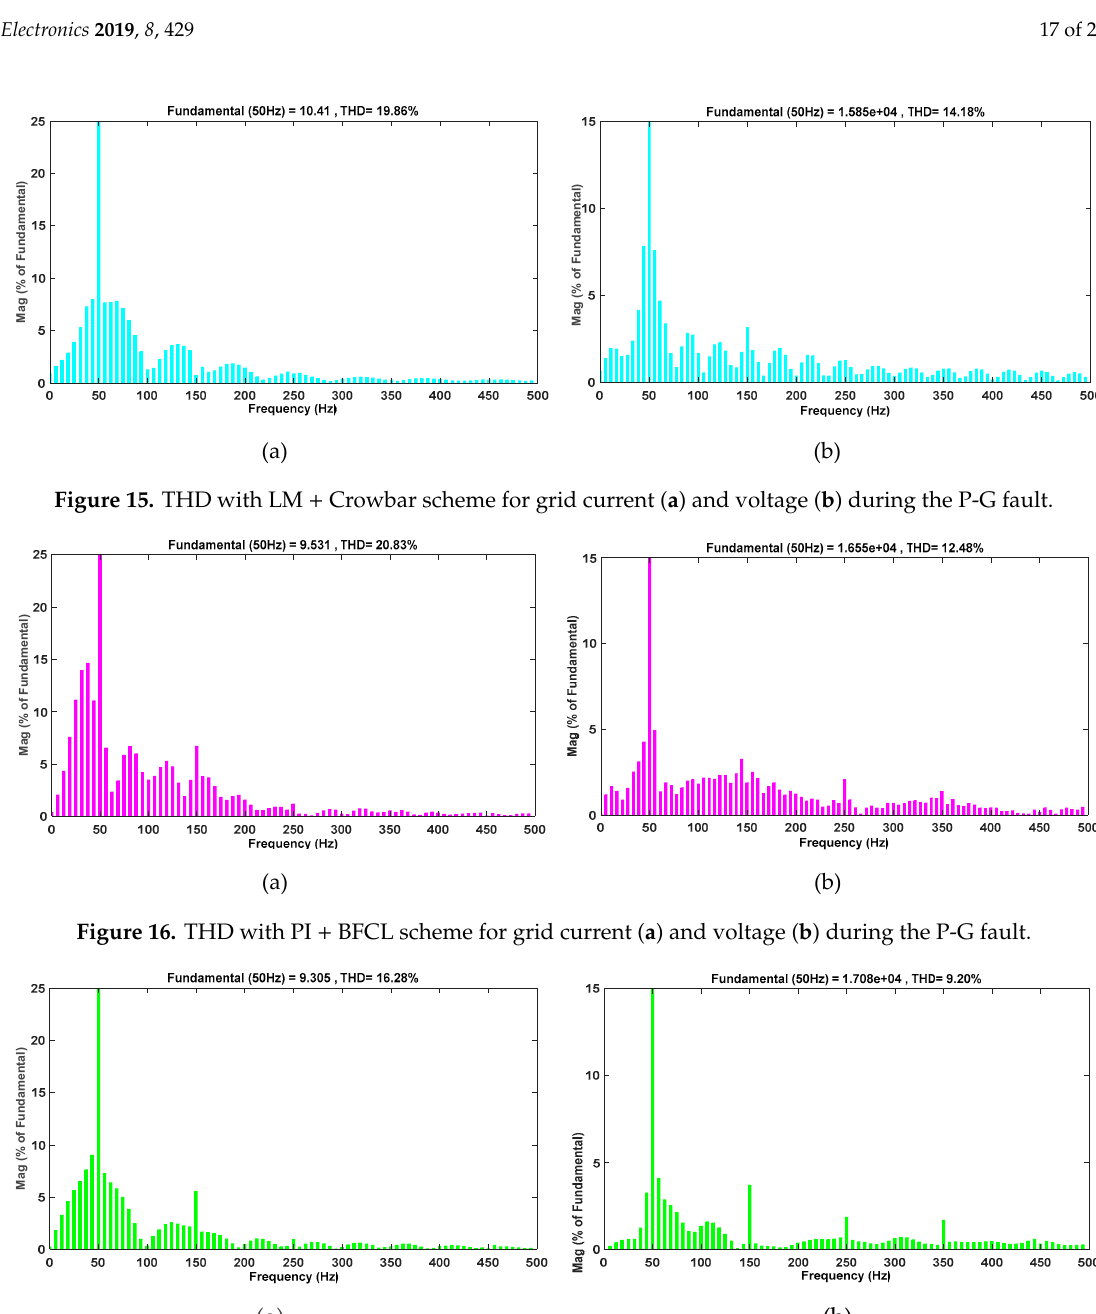
Figure 14. THD with LM controller for grid current ( a ) and voltage ( b ) during the P-G fault.